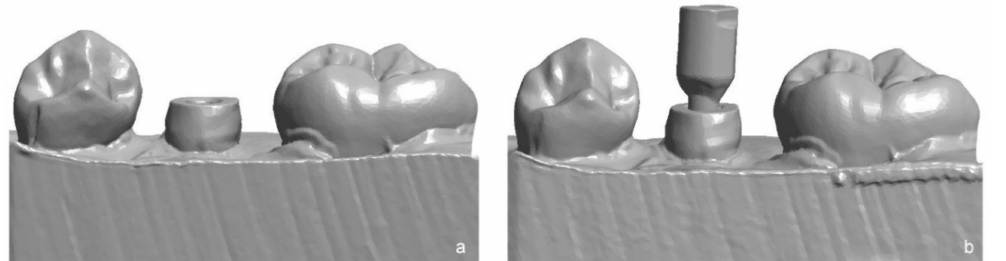
Figure 4. STL dataset of an intraoral scan without ( a ) and with scanpost (SP) inserted in root canal ( b ) for IOS Trios